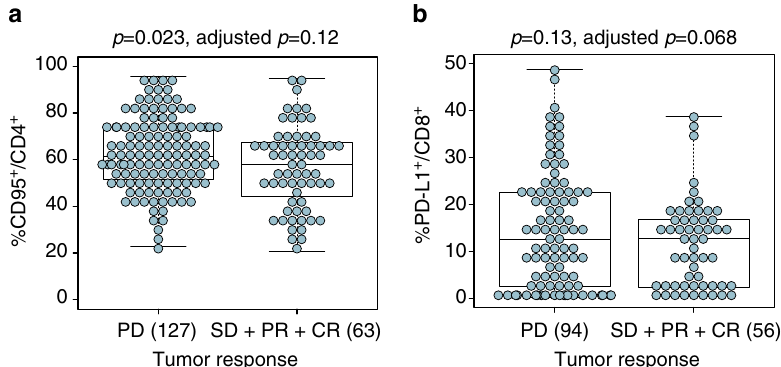
Fig. 5 Predictive values of PD-L1 + /CD8 + and CD95 + /CD4 + for RR to ipilimumab. a , b Statistical analyses of the clinical relevance of CD95 expression on CD4 + T cells as well as PD-L1 on CD8 + T cells according to RR (separating PD from SD, PR, or CR) were performed in univariate and multivariate regression assays. Each dot represents one patient. The box plots indicating the mean and s.e.m. of values for the binary separation are depicted (cf Supplementary Table 4). The absolute numbers of patients are indicated in all groups in parentheses. Box and whiskers plots are represented from the corresponding distribution a ,